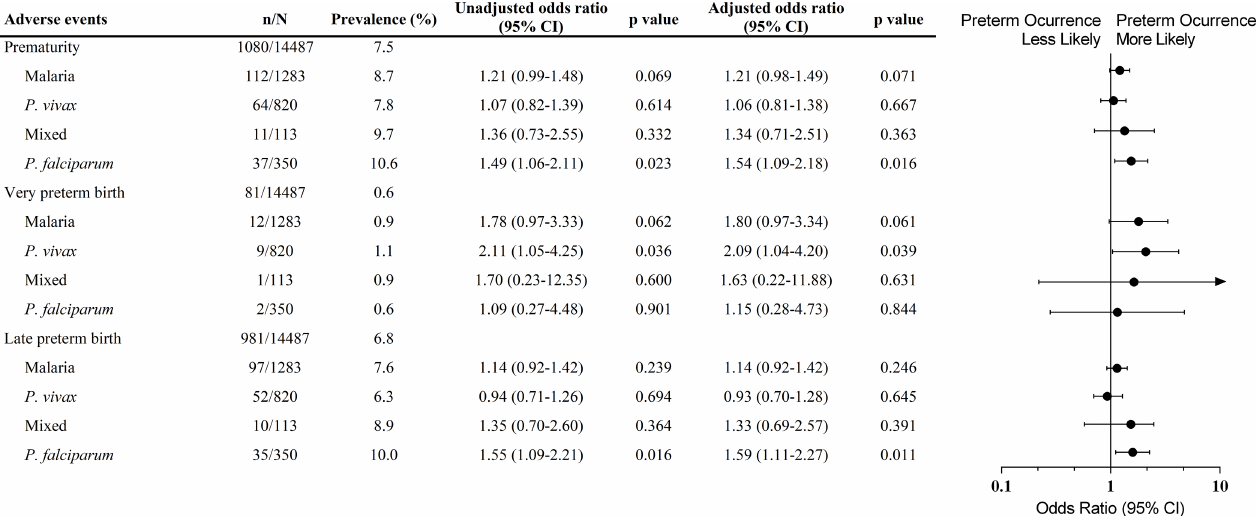
Fig 6. Forest plot of the odds ratio for prematurity in newborns from women infected during pregnancy compared to babies from non-infected women, according to Plasmodium species. Each model adjusting for maternal age, gravidity and years of formal education (less than 4 years). Mixed infection ( P . vivax and P . falciparum -infection). p values were estimated through logistic regression methods. n, number of events; N, total number in each group; CI, confidence interval. Prematurity was defined as birth < 37 weeks’ gestation; very preterm birth was defined as birth between (cid:21) 28 and < 32 weeks’ gestation, and late preterm birth was defined as birth between (cid:21) 32 and < 37 weeks’ gestation.